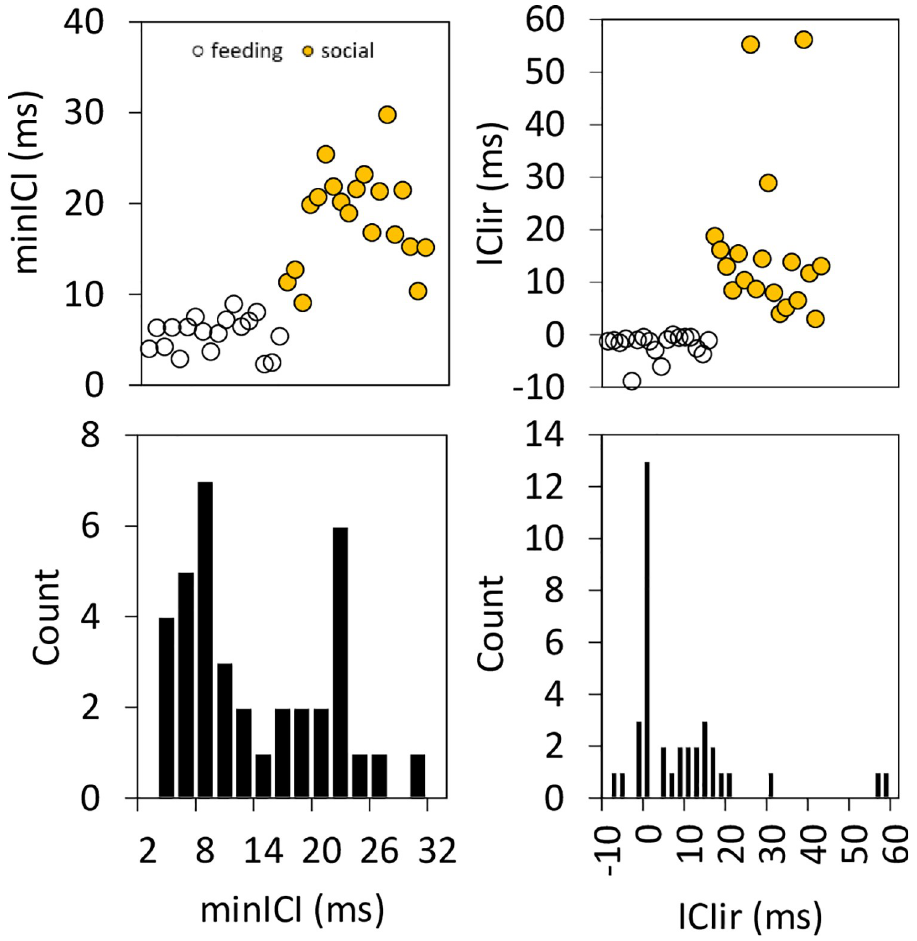
Fig 6. Scatterplot (upper panels) for minICI and ICIir from the 18 feeding click trains with terminal buzzes (yellow) and 19 social buzzes (black), and histograms (lower panels) with minICI and ICIir from all buzzes (feeding and